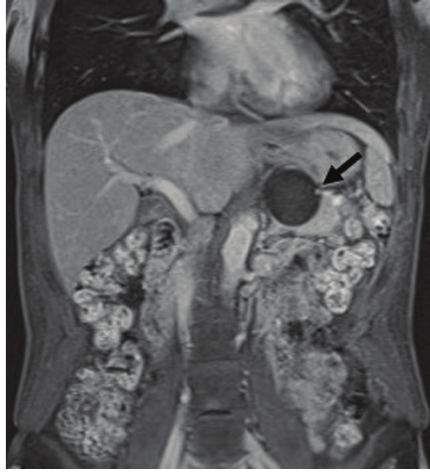
Figure 2: Axial T1-weighted magnetic resonance imaging showing homogeneous low signal intensity of the adrenal cystic lesion. A mural nodule with contrast enhancement (arrow) is observed.